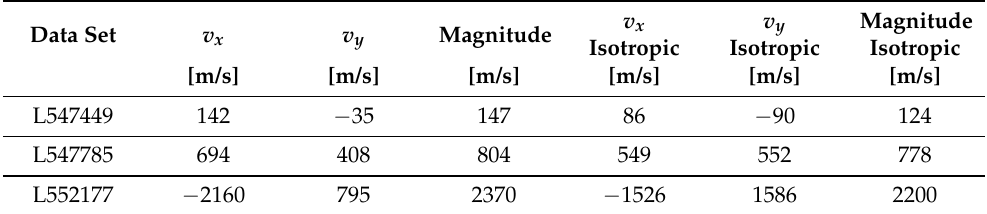
Table 2. Drift velocity estimates obtained from selected datasets. Table results correspond to the graphical presentation in Figure